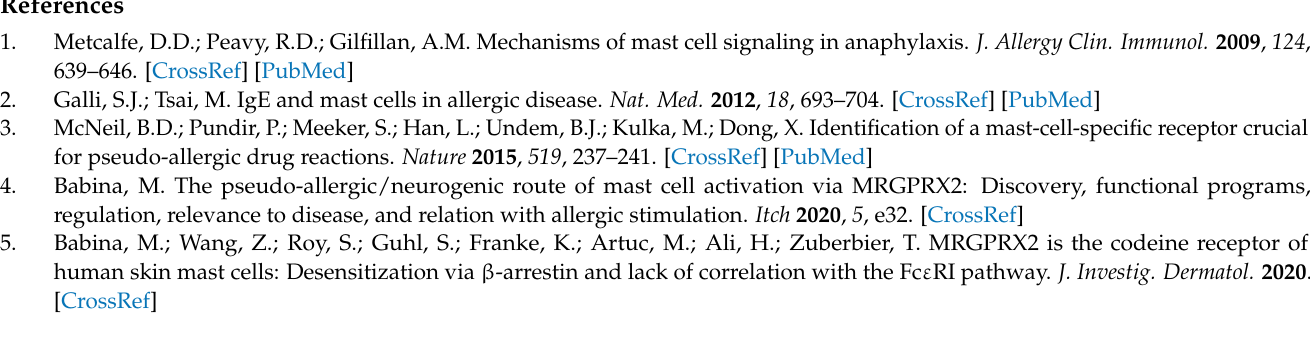
Figure S3: No effect of TSLP on the spontaneous or Fc ε RI-elicited proportion of CD107+ cells in multiple MC preparations. Figure S4: Comparison between Fc ε RI-triggered histamine release and CD107a exteriorization in the presence of TSLP. Figure S5: TSLP elicits phosphorylation of STAT5 in skin MCs. Figure S6: STAT5 is essential for TSLP to support MRGPRX2-mediated degranulation— insights from RNAi-mediated